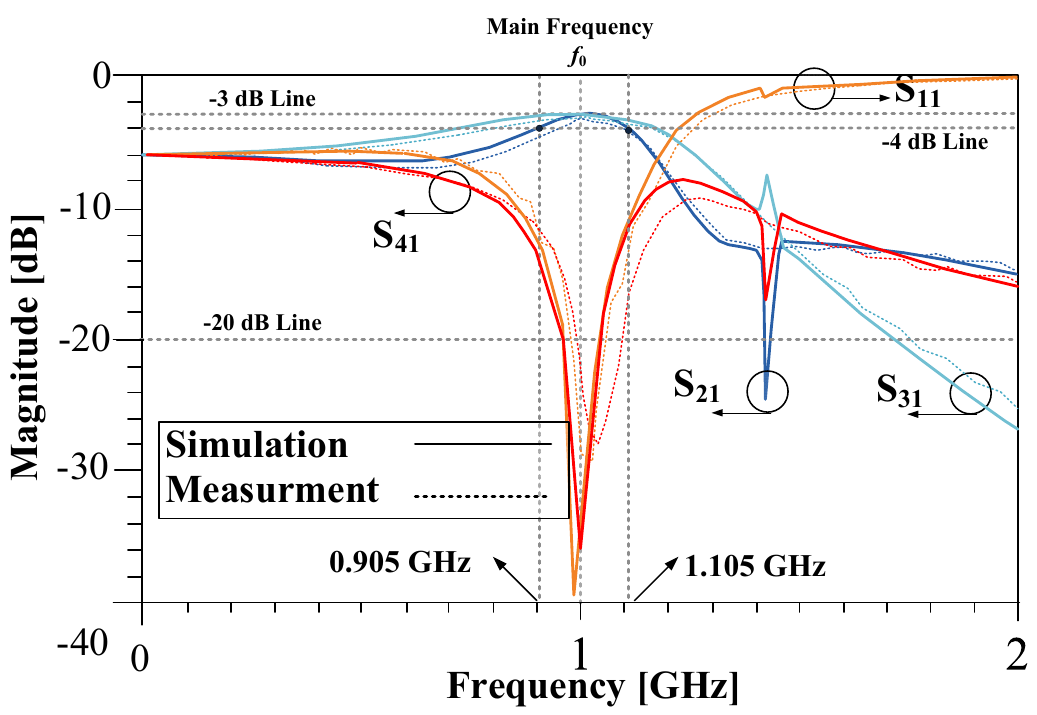
Figure 16. In-band simulated and measured S-parameters of the proposed BLC. The result of the in-band phase difference is depicted in Figure 17. The measured phase difference of the presented BLC is less than 90 ± 0.5° at the main frequency. Moreover, the phase difference is flat, and its value is near 90° at the operating bandwidth.